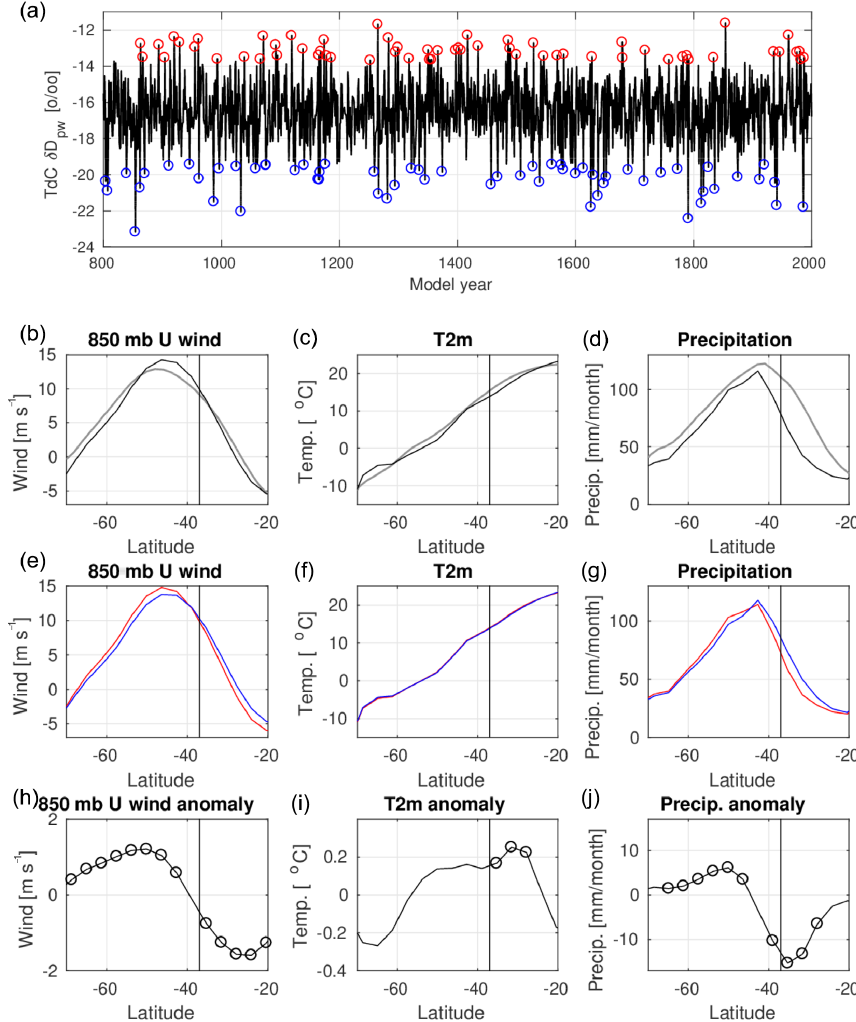
Figure 7. Zonal mean changes in wind, temperature and precipitation related to δ D variability at TdC. (a) Time series of simulated precipitation-weighted annual mean δ D at TdC, with values above and below the 95th percentile indicated with red and blue circles, re- spectively. This selection of high and low δ D is used to define the data in (e–g) . (b–d) Annual modeled (black) South Atlantic zonal mean (30 to 0 ◦ W) westerly wind speed (850mbar U wind, positive towards east), 2m temperature (T2m) and precipitation compared to the 20th Century Reanalysis climatology 1981–2010 (gray) (Compo et al., 2011). (e–g) Composites of annual modeled zonal mean (30 to 0 ◦ W) westerly wind speed (850mbar U wind), 2m temperature (T2m) and precipitation for high (red) and low (blue) δ D at TdC defined in (a) . (h–j) High minus low anomalies of model output are shown in (e) – (f) . Circles indicate significant anomalies ( p <0.01) calculated using two-tailed Student’s t test. The vertical bars in (b) – (j) show the latitude of NI at 37 ◦